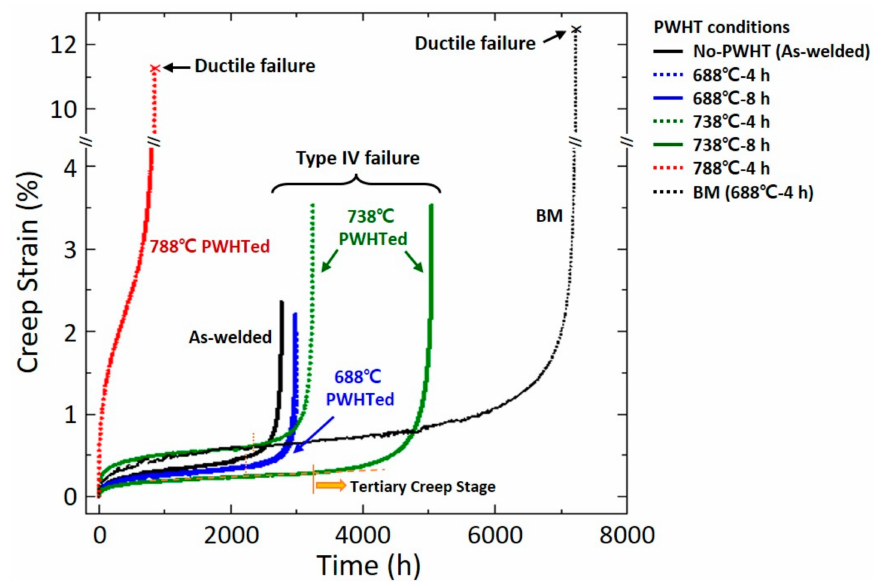
Figure 2. Comparison of the creep curves at 600 ◦ C/200 MPa under various PWHT